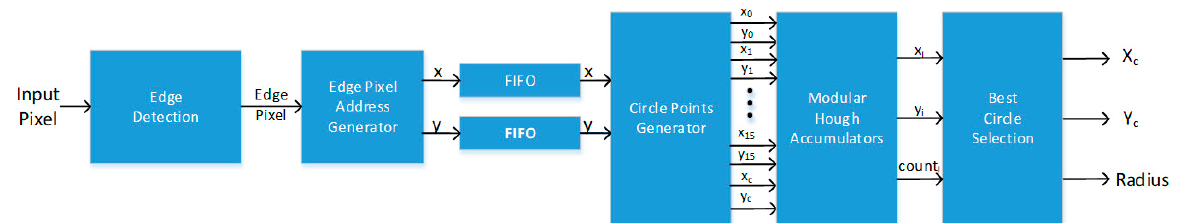
Figure 3. Block diagram of the architecture design for the iris boundary detection module in the iris recognition algorithm.